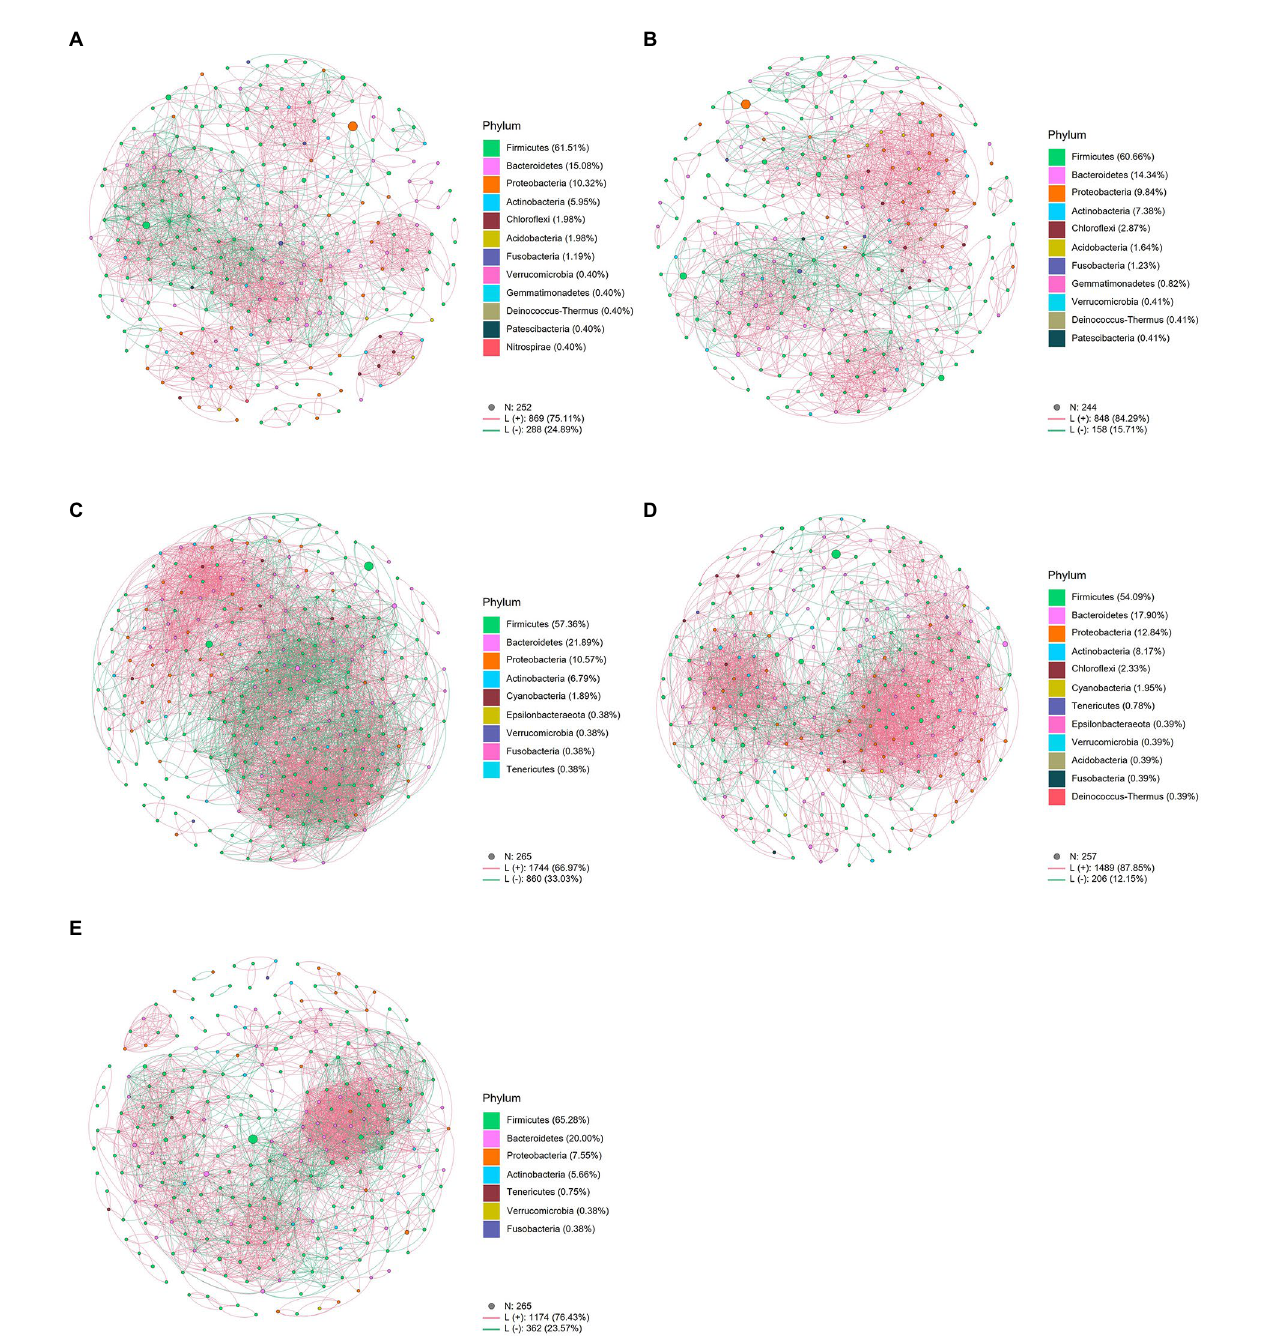
FIGURE 4 (A) Network analysis of the intestinal bacterial community in patients before metformin treatment. (B) Network analysis of the intestinal bacterial community in patients before liraglutide treatment. (C) Network analysis of the intestinal bacterial community in patients after metformin treatment. (D) Network analysis of the intestinal bacterial community in patients after liraglutide treatment. (E) Network Analysis of the intestinal bacterial community in healthy